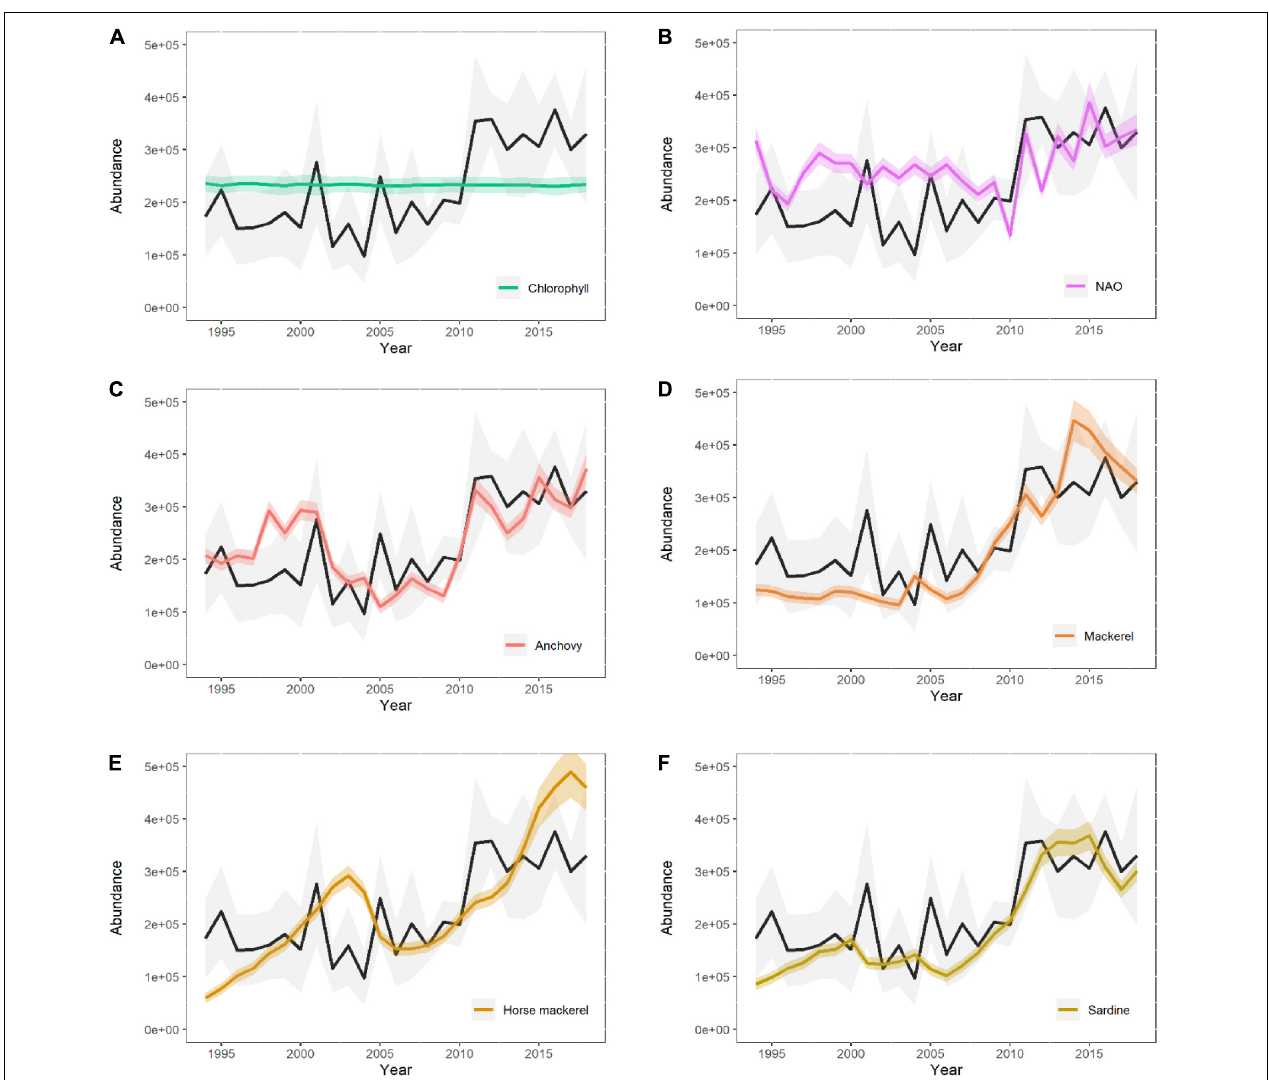
FIGURE 7 | Abundance estimates predicted by the baseline spatio-temporal model (black line) and by the covariates-based model (with no random effects, colored line) so that the contribution made by each variable (A–F) can be visualized. Only drivers identified as relevant by AIC score are